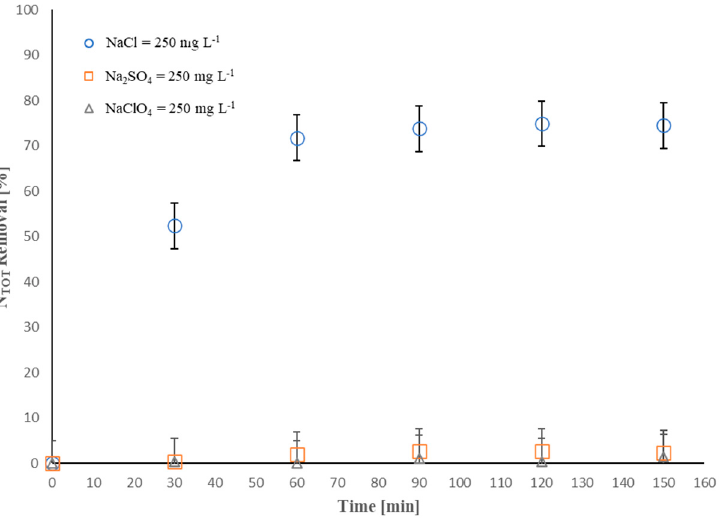
Figure 1. Effect of electrolyte composition on N TOT removal (%): I = 0.15 A, [ N TOT ] 0 = 13 mg·L − 1 ; anode active area = 50 cm 2 .